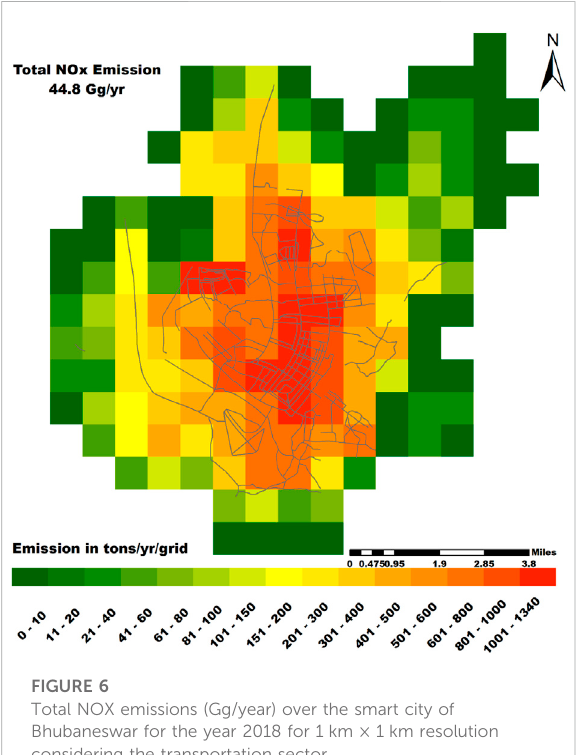
FIGURE 6 Total NOX emissions (Gg/year) over the smart city of Bhubaneswar for the year 2018 for 1 km × 1 km resolution considering the transportation sector.